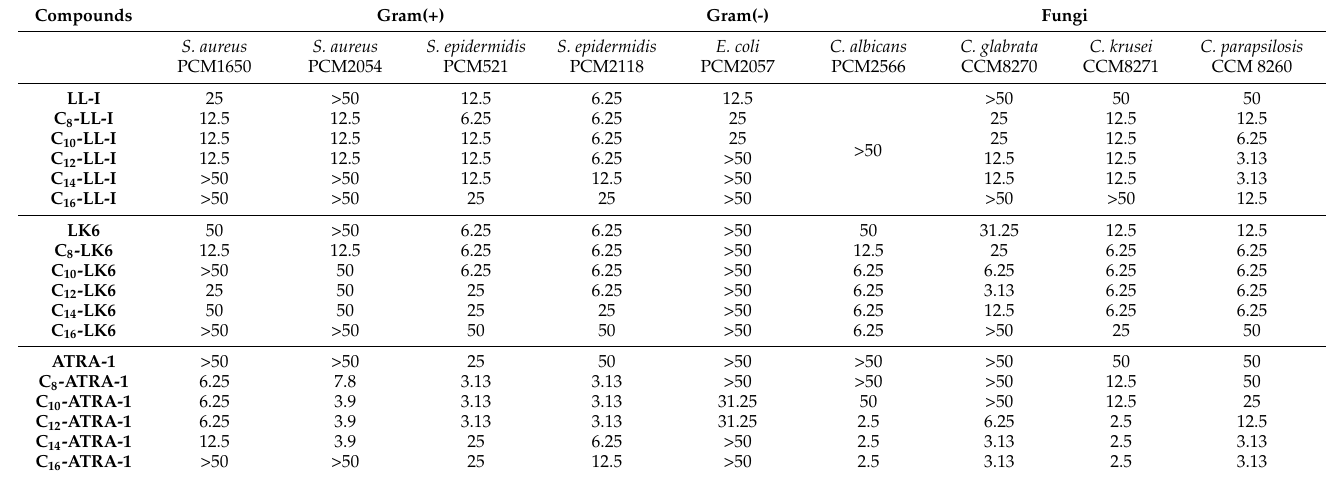
Table 1. MIC ( µ g/mL) values determined for peptide derivatives.